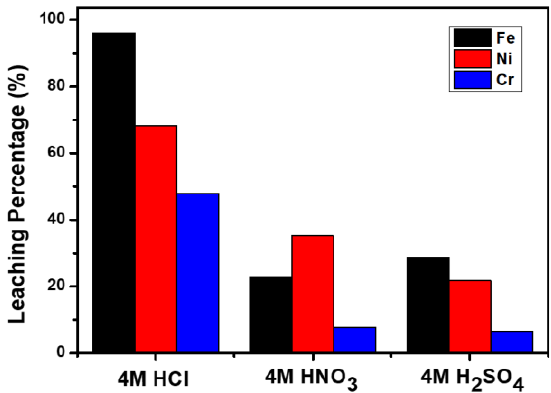
Figure 3. The effect of acids on the leaching percentage.